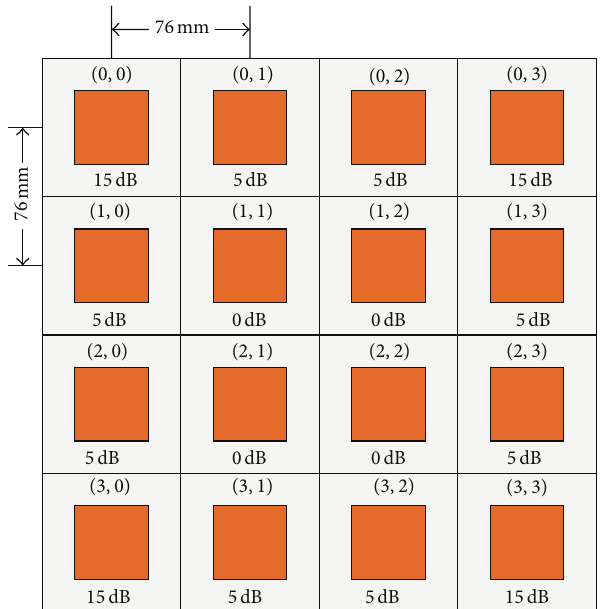
Figure 8: Attenuation map for each element for optimum tapering in